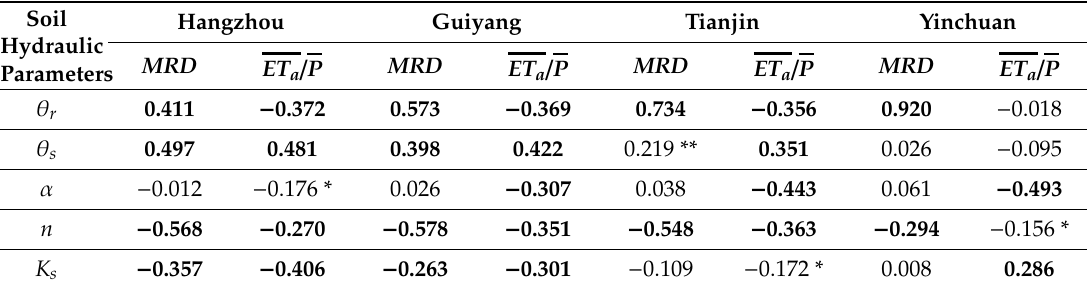
Table 5. Spearman’s rank correlation coe ffi cients of soil hydraulic parameters for sandy loam with mean relative di ff erence ( MRD ) of soil moisture and mean annual ratio of actual evapotranspiration ( ET a ) over precipitation ( P